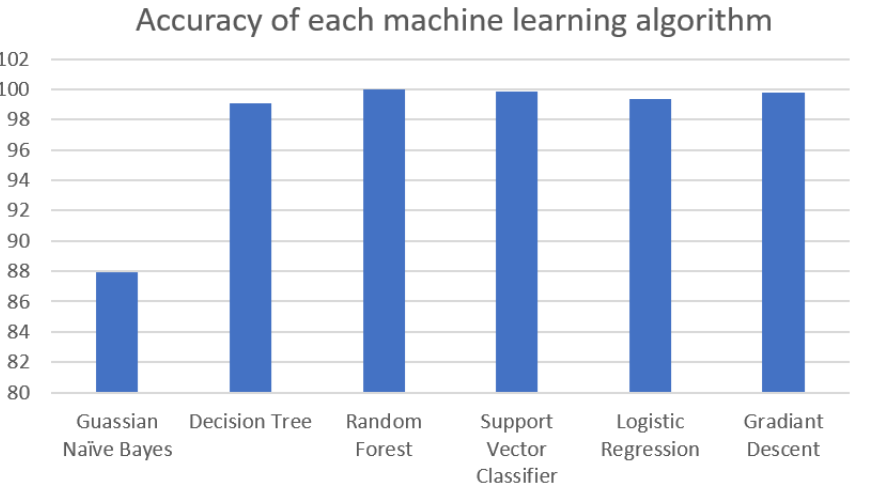
Figure 3. Detection